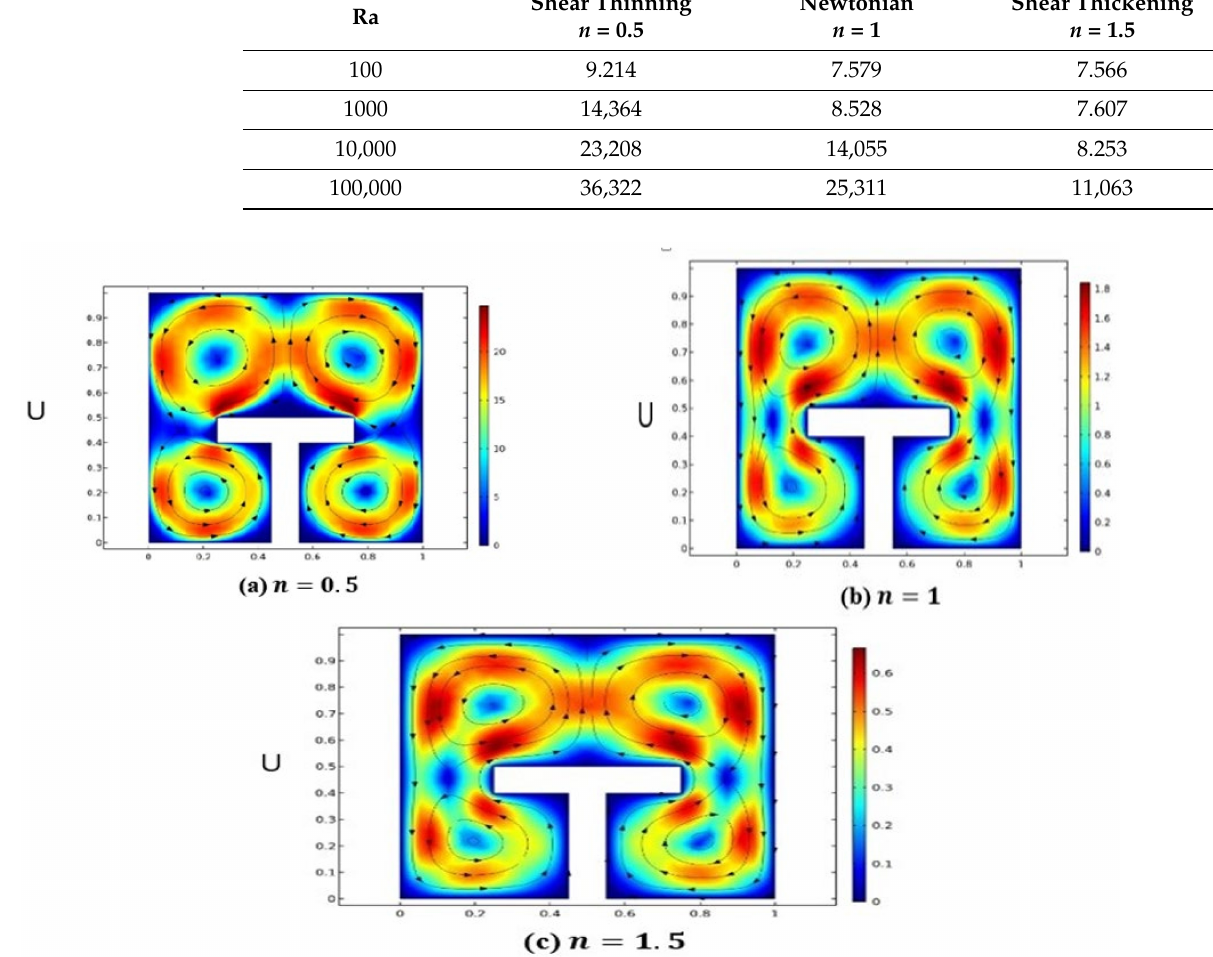
Figure 6. Variation in velocity distribution against ( n